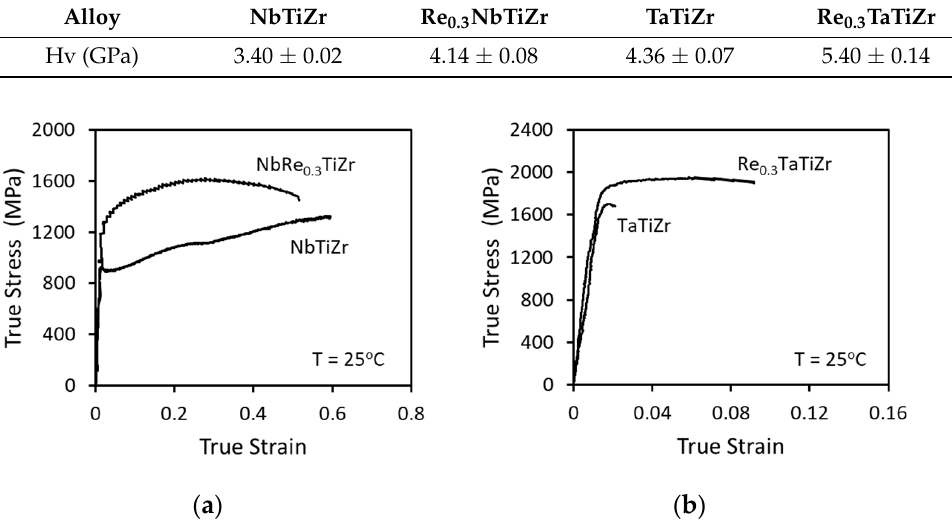
Figure 1. True stress versus true strain deformation curves for ( a ) NbTiZr and Re 0.3 NbTiZr and ( b ) TaTiZr and Re 0.3 TaTiZr acquired at room temperature.